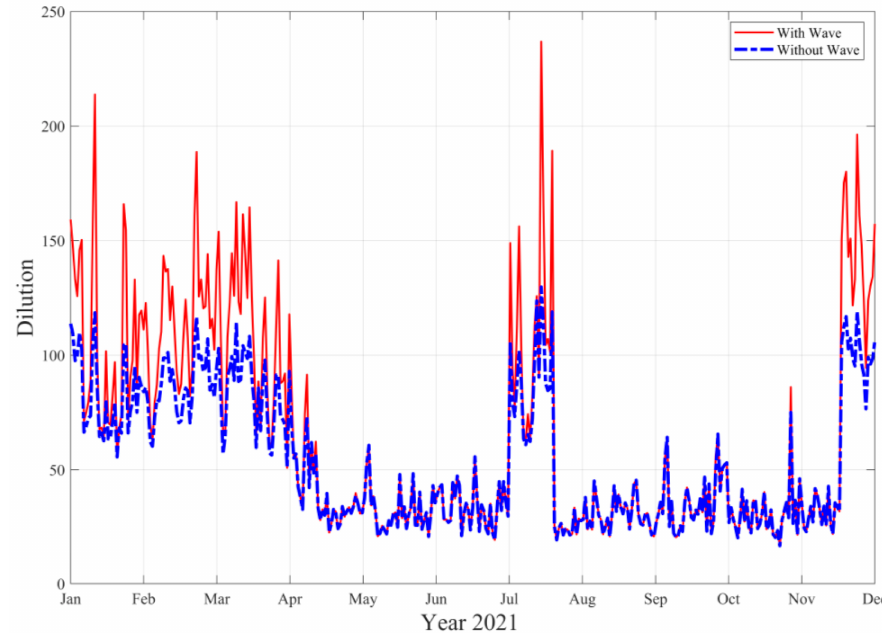
Figure 13. Santa Marta’s submarine outfall dilution without and with wave effects.